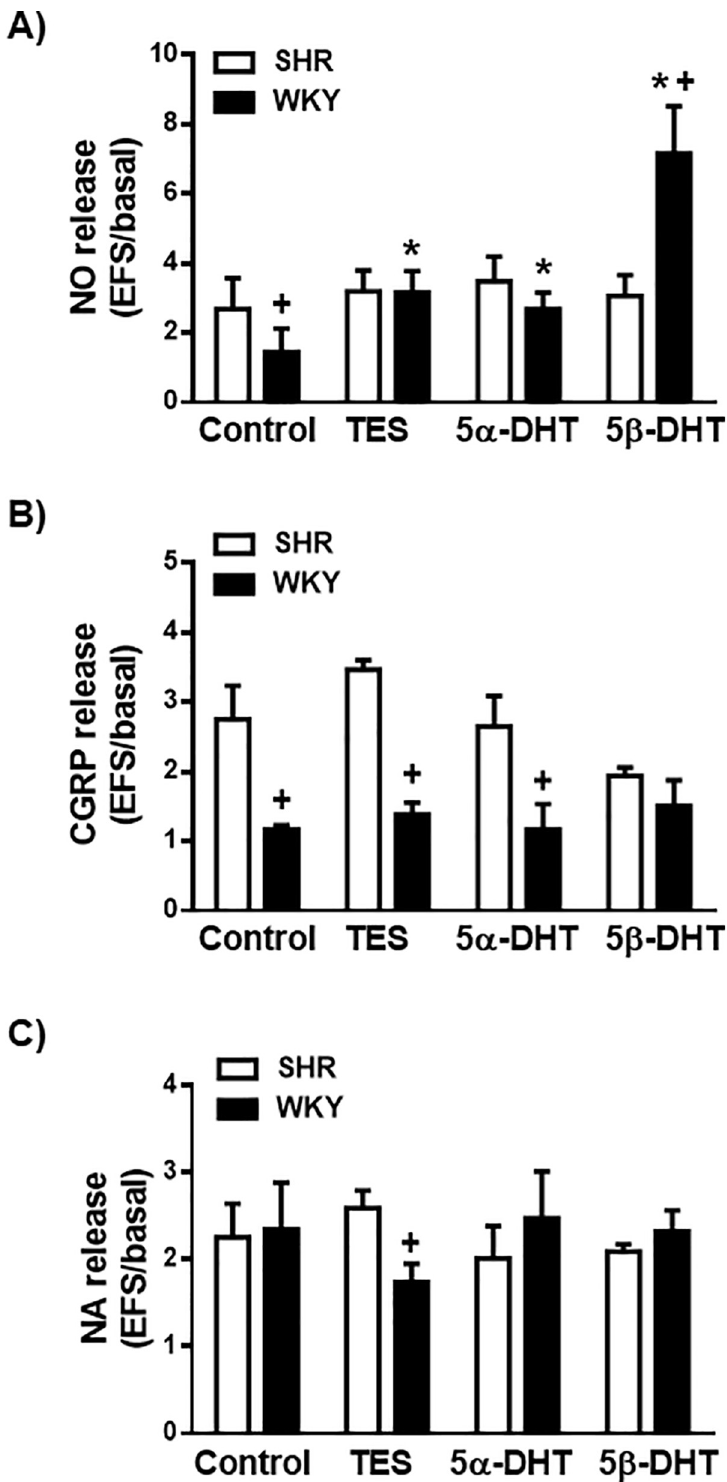
Fig 1. Effect of androgens on the neuronal NO, CGRP and NA release. Effect of 10 nM testosterone (TES), 5 α - dihydrotestosterone (5 α -DHT) and 5 β - dihydrotestosterone (DHT) on the release of neuronal NO (A), CGRP (B) and NA (C) in the mesenteric artery of hypertensive (SHR) and normotensive (WKY) rats. Results (mean ± SEM) are expressed as the ratio between electrical field stimulation (EFS)-induced neurotransmitter release and basal release.